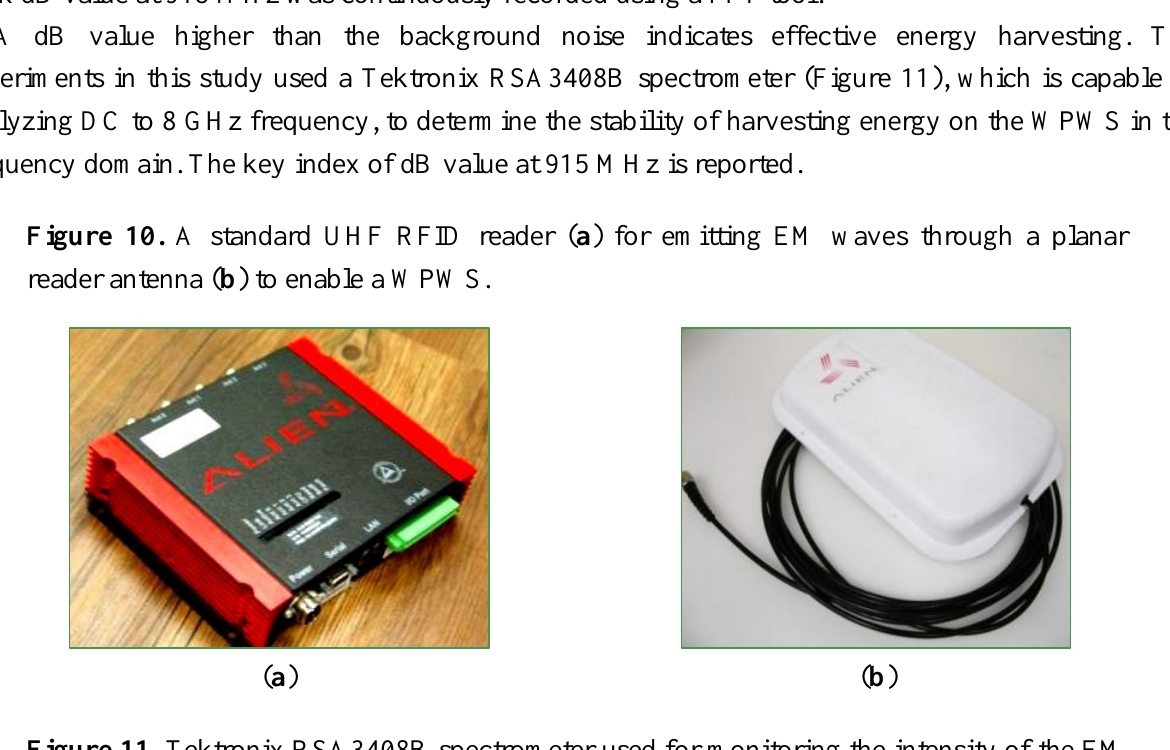
Figure 11. Tektronix RSA3408B spectrometer used for monitoring the intensity of the EM wave power received by the